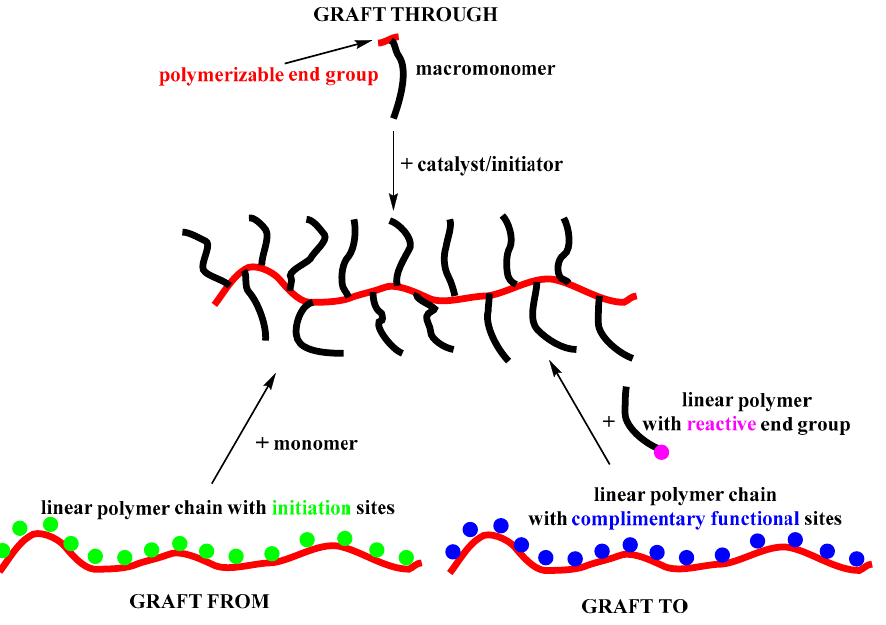
Figure 6. Methods for the synthesis of molecular brushes.